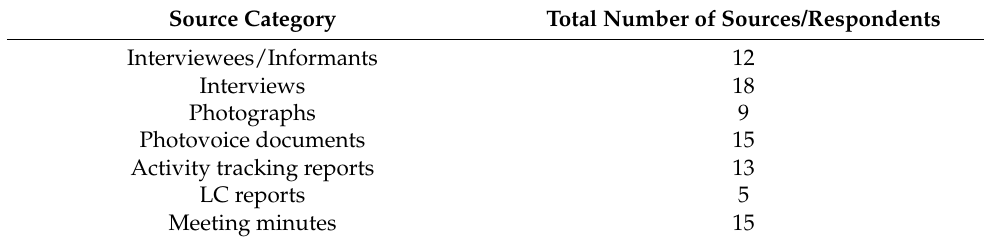
Table 1. Data sources and documents for this